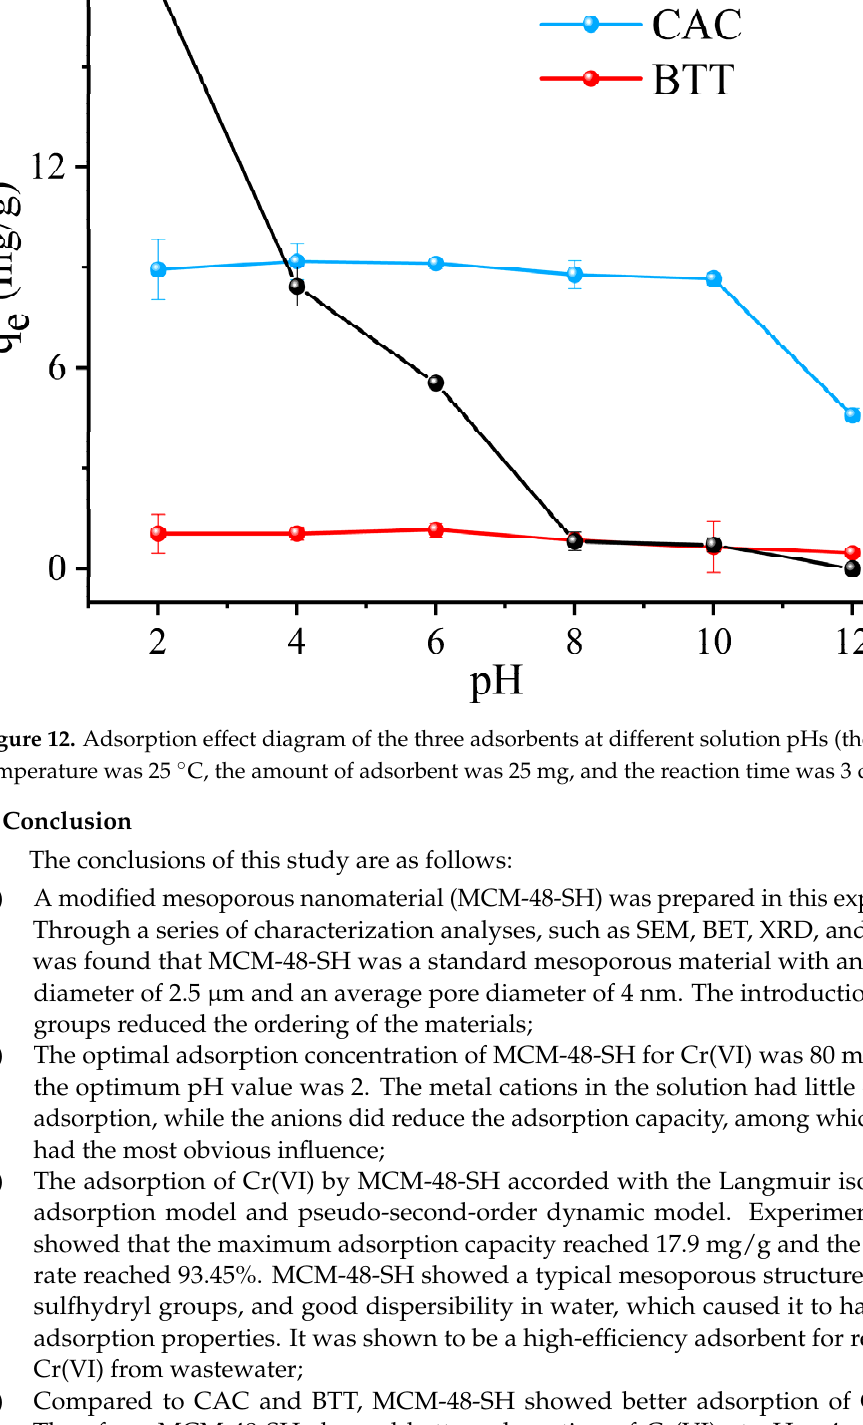
14 of 19 Figure 11. Adsorption effect diagram of MCM-48-SH under the three different coexisting ions in solution (the reaction temperature was 25 °C, the amount of adsorbent was 25 mg, the pH of the solution was 2, and the reaction time was 3 d). 3.2.6. Adsorption Comparison between the Traditional Adsorbent and MCM-48-SH